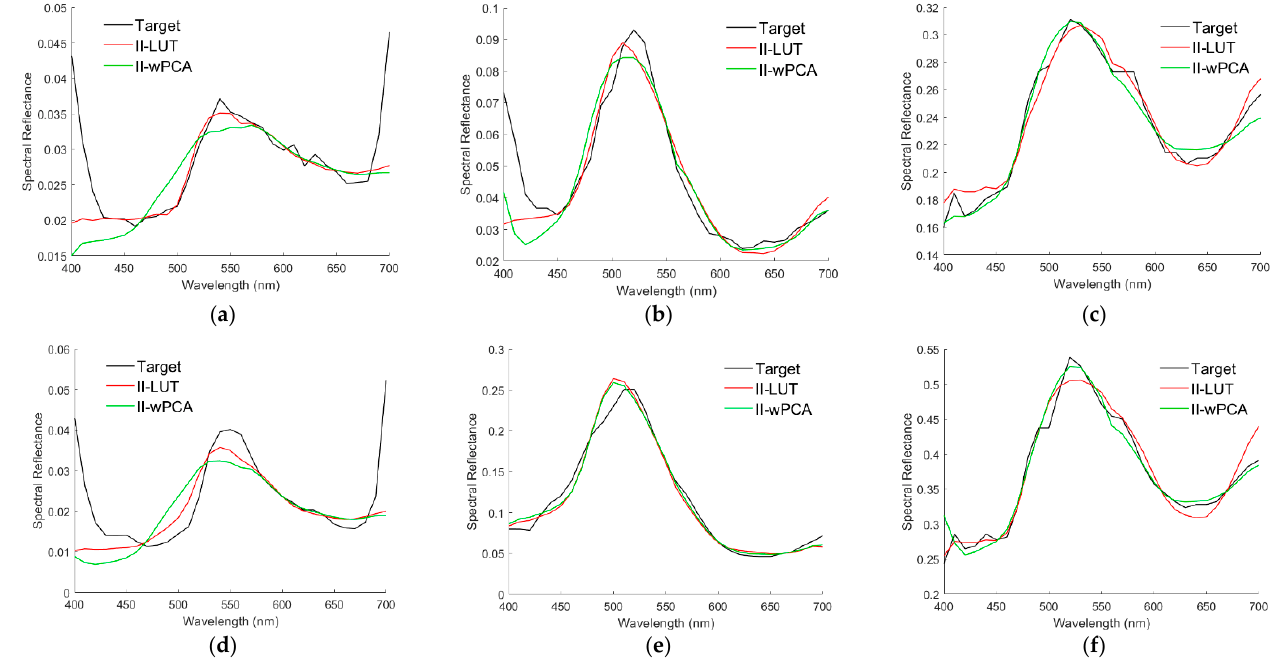
Figure 23. ( a – f ) showing the target spectral reflectance of the pixel at the center of the white circle in Figure 22a–f, respectively, where the recovered spectral reflectance using the II-LUT and II-wPCA methods are shown.